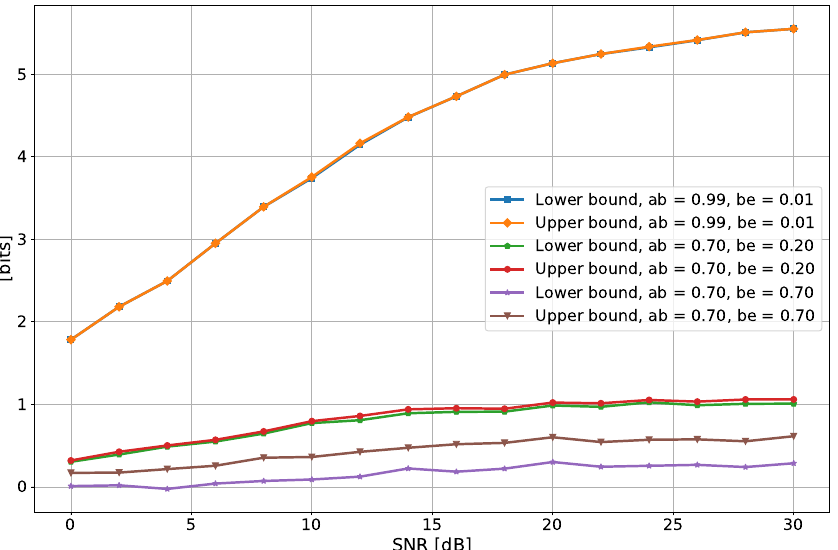
Figure 10. Secrecy key rate as a function of the SNR of Alice and Bob, for different values of the correlation and with 4 filters. In the legend, “ab” and “be” stand for Alice–Bob correlation and Bob–Eve correlation.